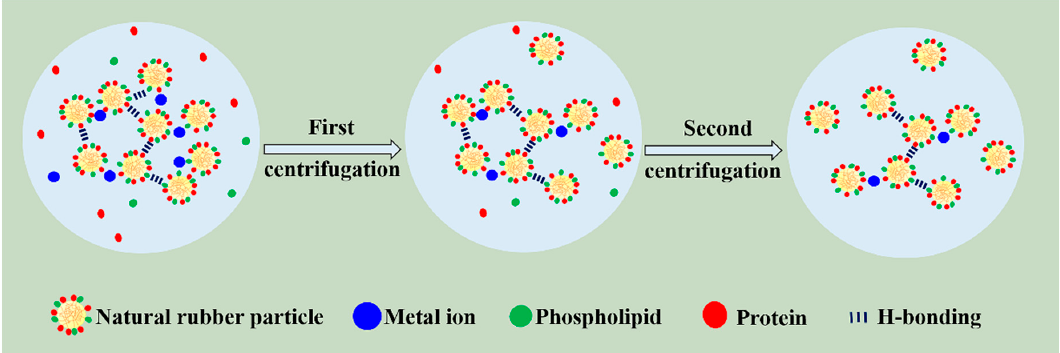
Figure 4. Schematic of the natural network structure in NR.